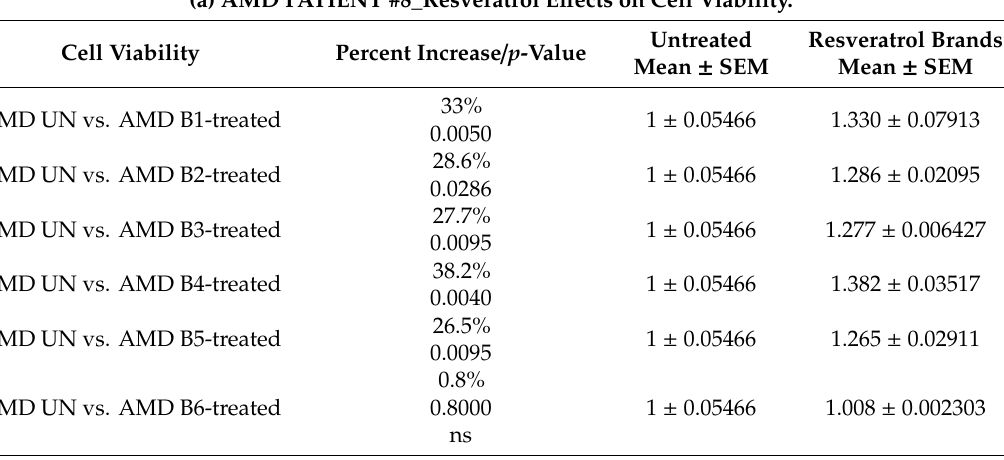
Figure 10. Effects of resveratrol formulations on cell viability ( A ) and ROS levels ( B ) in AMD patient